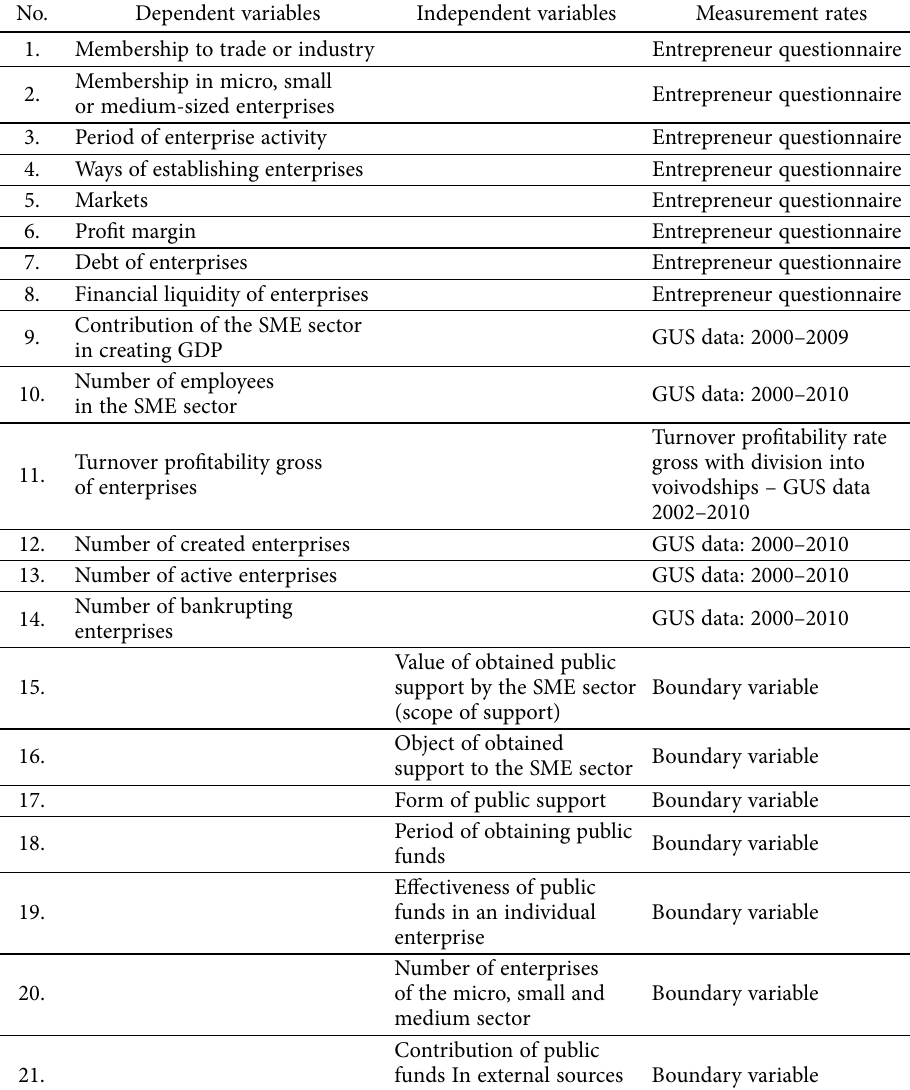
Table 1. Assumptions concerning dependence of the analyzed variables in accordance with the QCA model